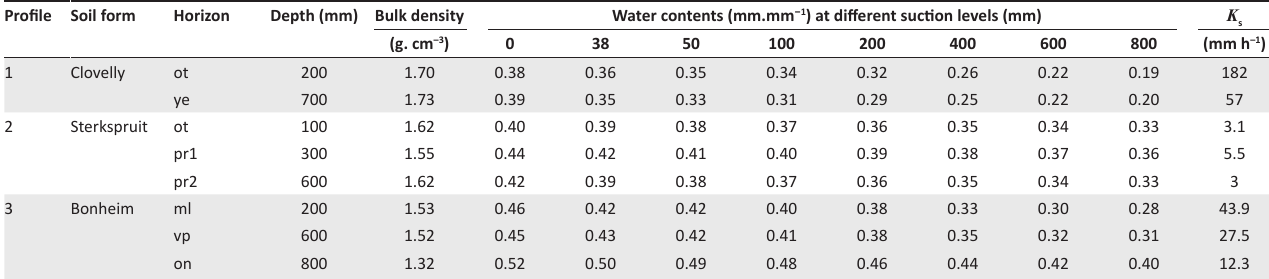
TABLE 2: Physical measurements of three modal profiles. Profile Soil